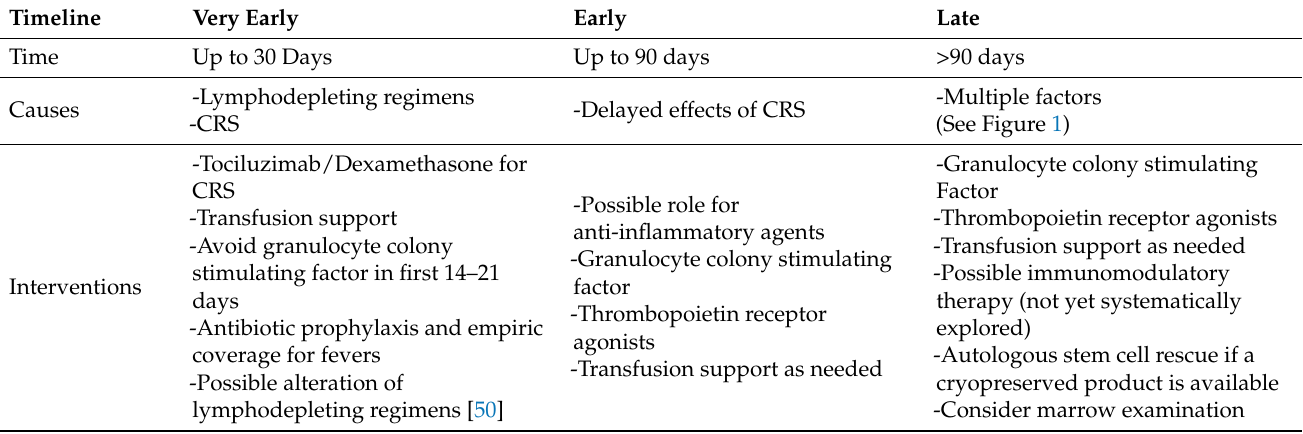
Table 2. Possible classification and management of post-CAR-T